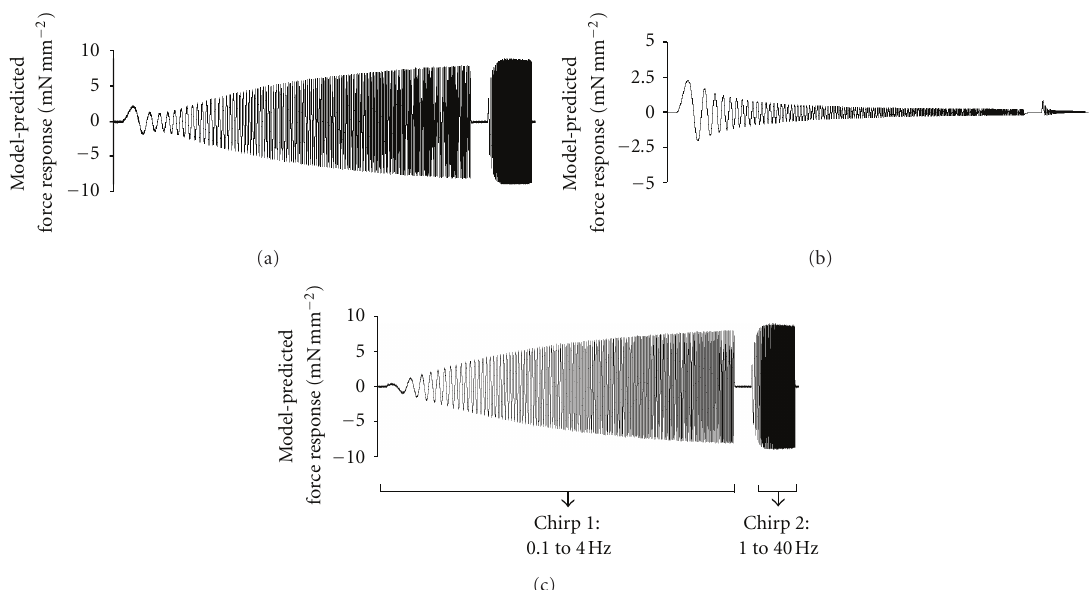
Figure 1: Representative model-predicted force response to chirp-length perturbation for a control-rat fiber (i.e., cTnC WT fiber). (a) Total force response that includes force components due to low-frequency XB recruitment component, E 0 ∗ η ( t ), and high-frequency XB distortion component, E ∞∗ x ( t ). (b) Force response due to low-frequency XB recruitment component, E 0 ∗ η ( t ). (c) Force response due to high-frequency XB distortion component, E ∞∗ x ( t ). E 0 and E ∞ represent sti ff ness magnitudes that scale the contributions of recruitment and distortion components to total sti ff ness. η ( t ) and x ( t ) are variables that describe the dynamic changes in the XB recruitment and distortion components due to changes in muscle length. Two chirps were administered to emphasize low- and high-frequency components of the force response: from 0.1 to 4Hz over 40s in chirp 1 and from 1 to 40 Hz over 5 s in chirp